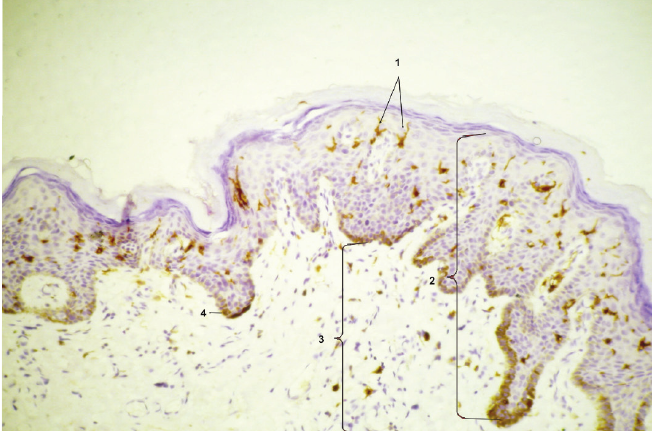
FIGURE 1 - Immunohistochemical staining of a serial section of positive skin control. 1 =CD1a+ DC, 2 =anal squamous epithelium, 3 =cells of lamina propria, 4 =melanocyte or CD1a+DC in basal layer, DC=dendritic cells. Magnification=100X.